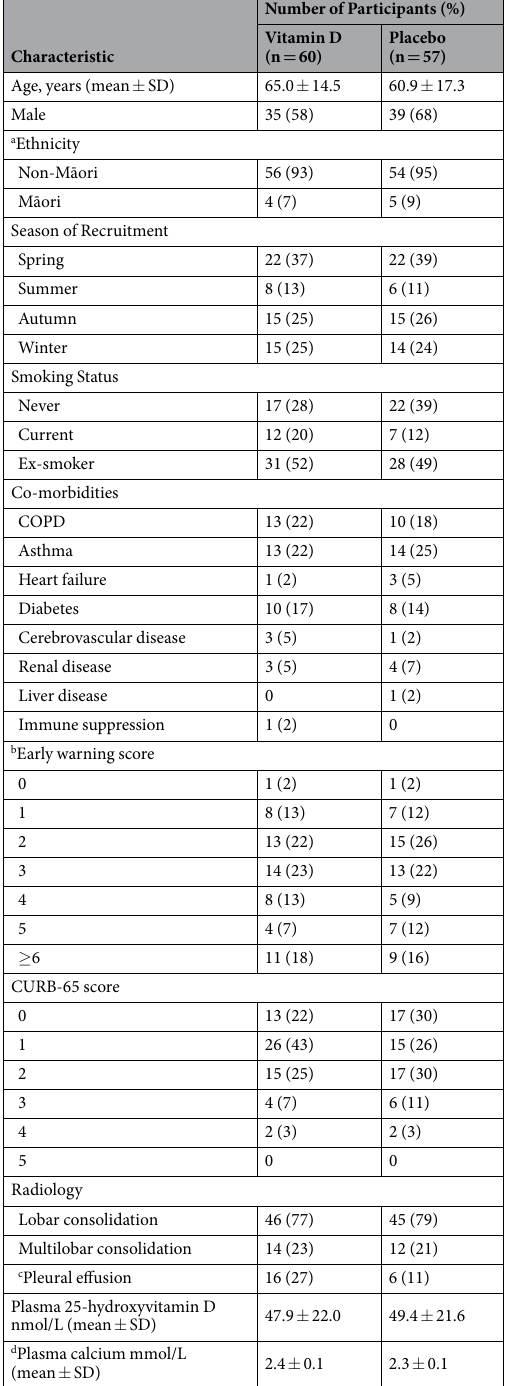
Table 1. Baseline Characteristics. a Participants could identify with more than one ethnic group, therefore percentages do not add to 100. One participant in the vitamin D group declined to answer. b Data was not obtained for 1 patient in the vitamin D treatment group. c Pleural effusion was not assessable on radiographs for 4 patients (vitamin D n = 1, placebo n = 3). d Plasma calcium values stated are corrected for plasma albumin